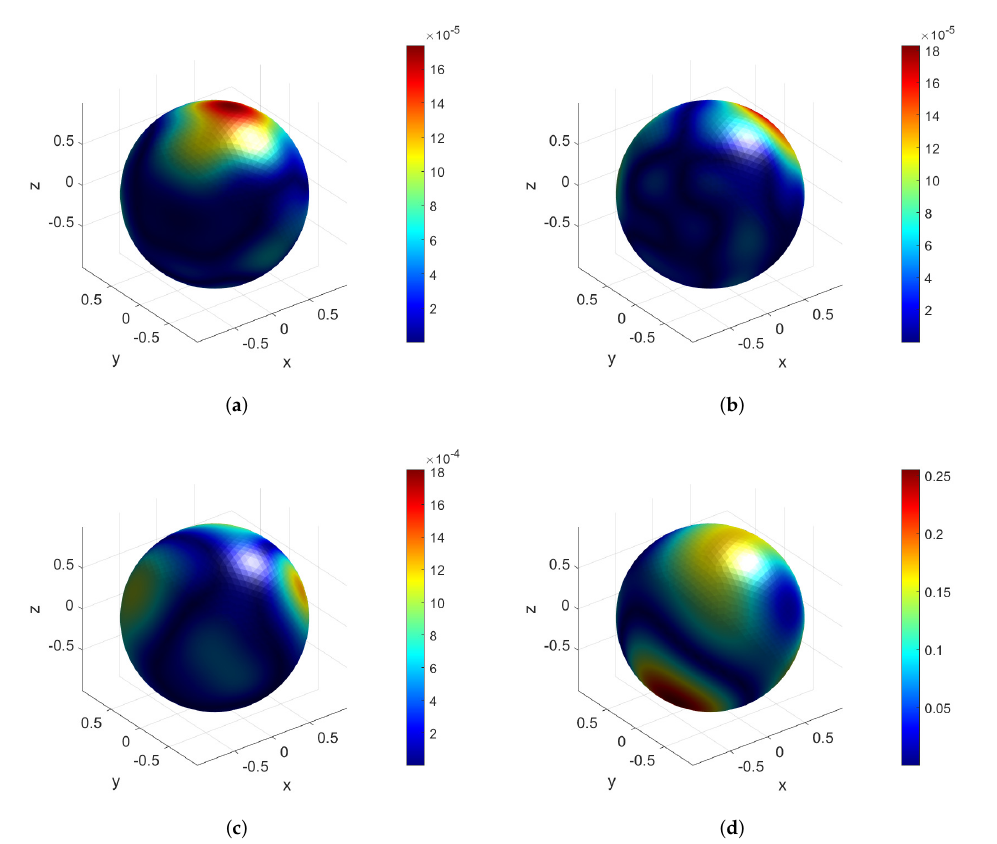
Figure 3. Example 1: Random few snapshots of absolute error distribution under width = 50 and depth = 4 by using ( a ) 2500 training data points; ( b ) 1500 training data points; ( c ) 100 training data points; ( d ) 10 training data